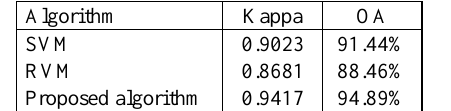
Table 1. Kappa coefficient and overall classification